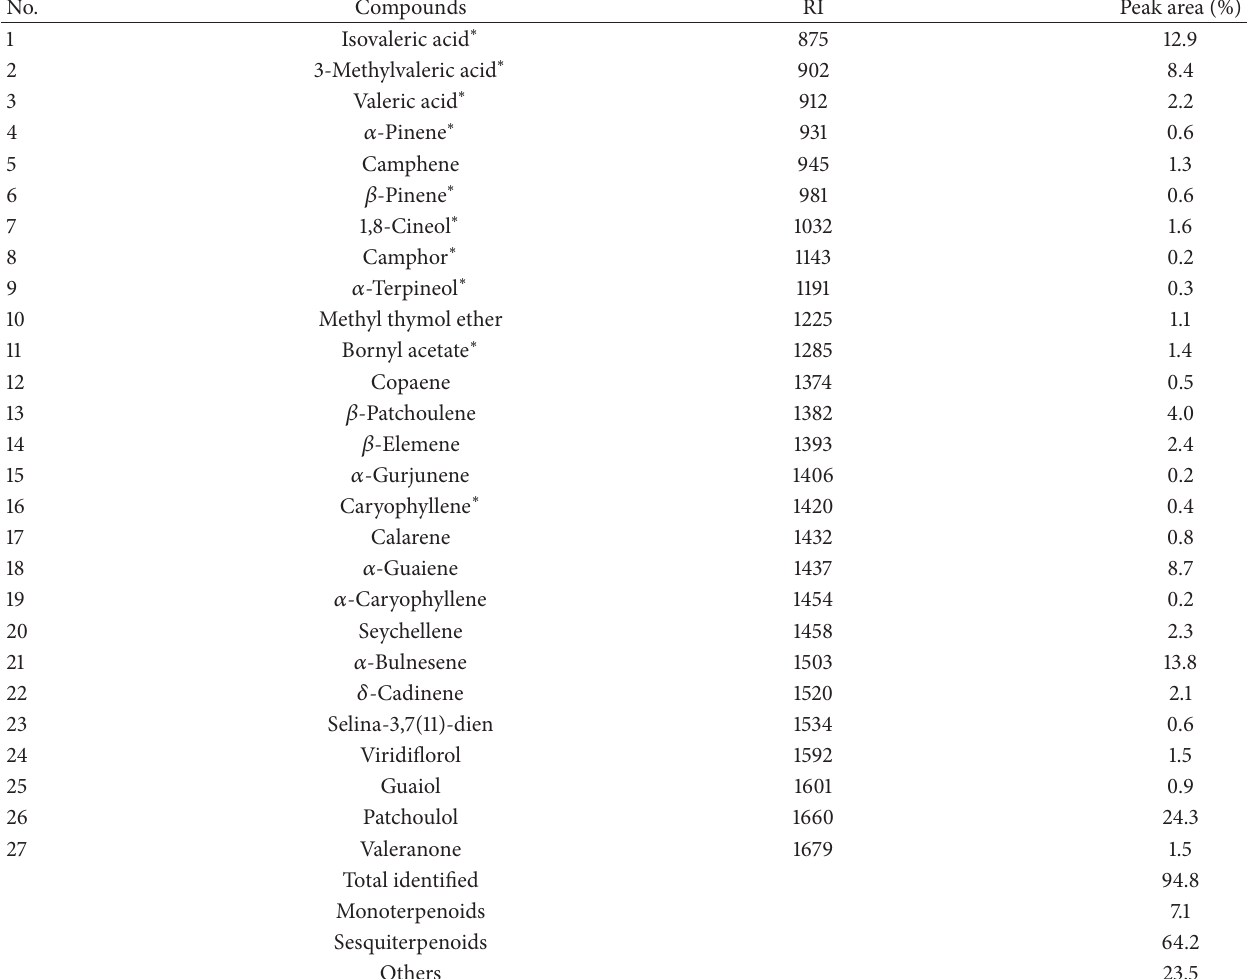
Table 1: GC-MS analysis of essential oil derived from Valeriana jatamansi